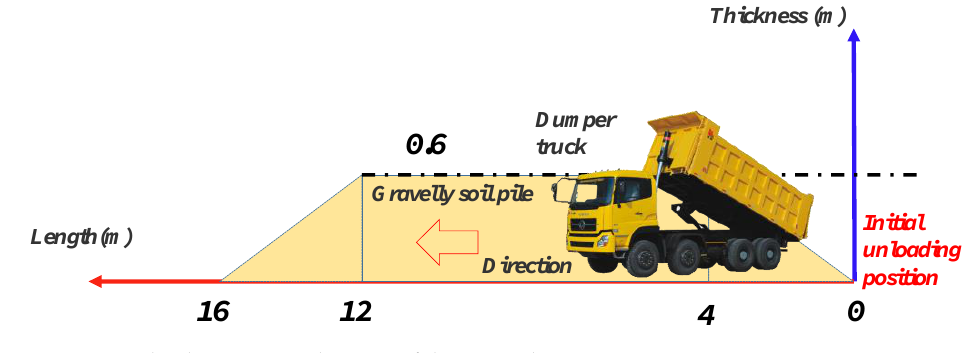
Figure 5. Unloading process diagram of dump truck.